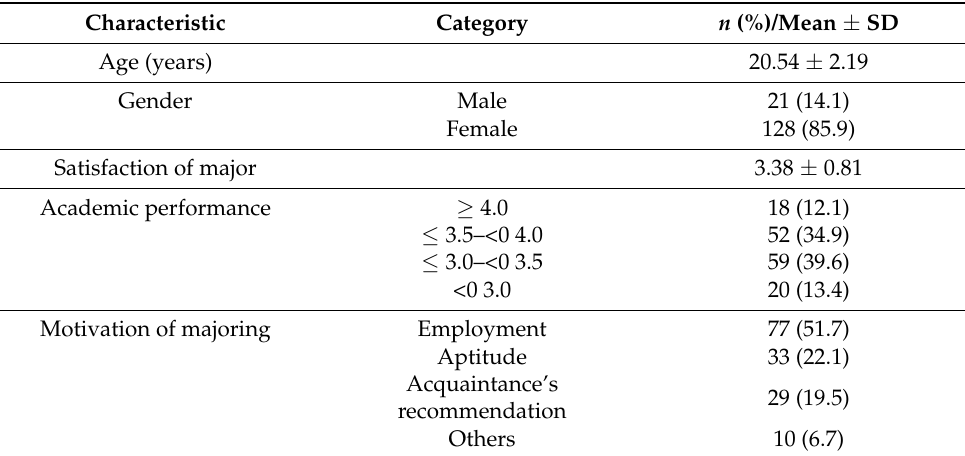
Table 1. General characteristics of participants ( n = 149).